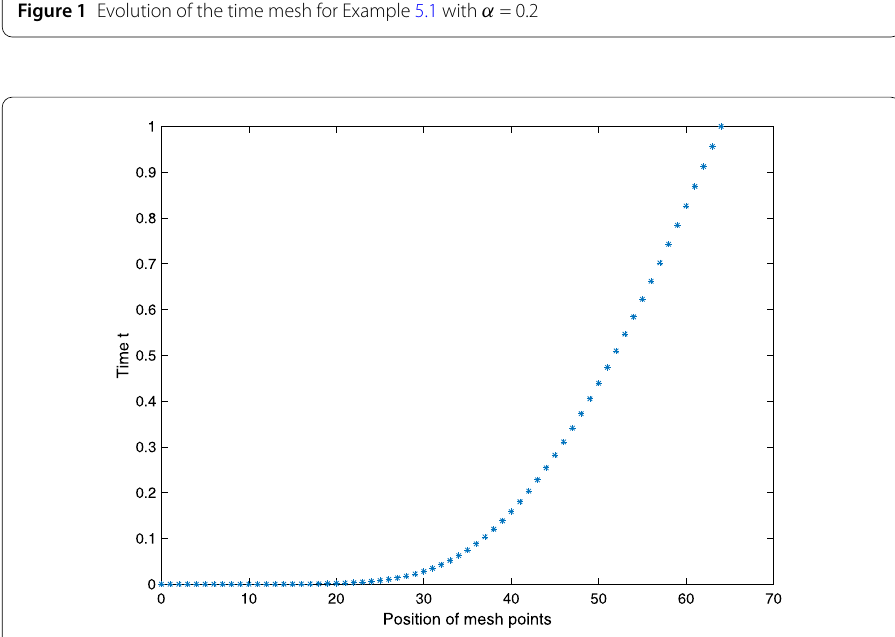
Figure 2 Final computed time mesh for Example 5.1 with α = 0.2